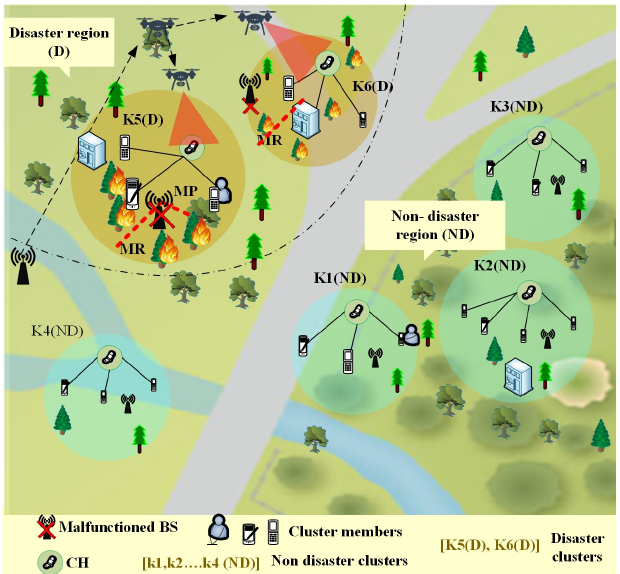
Algorithm 1 LGRU ‐ based weather and event